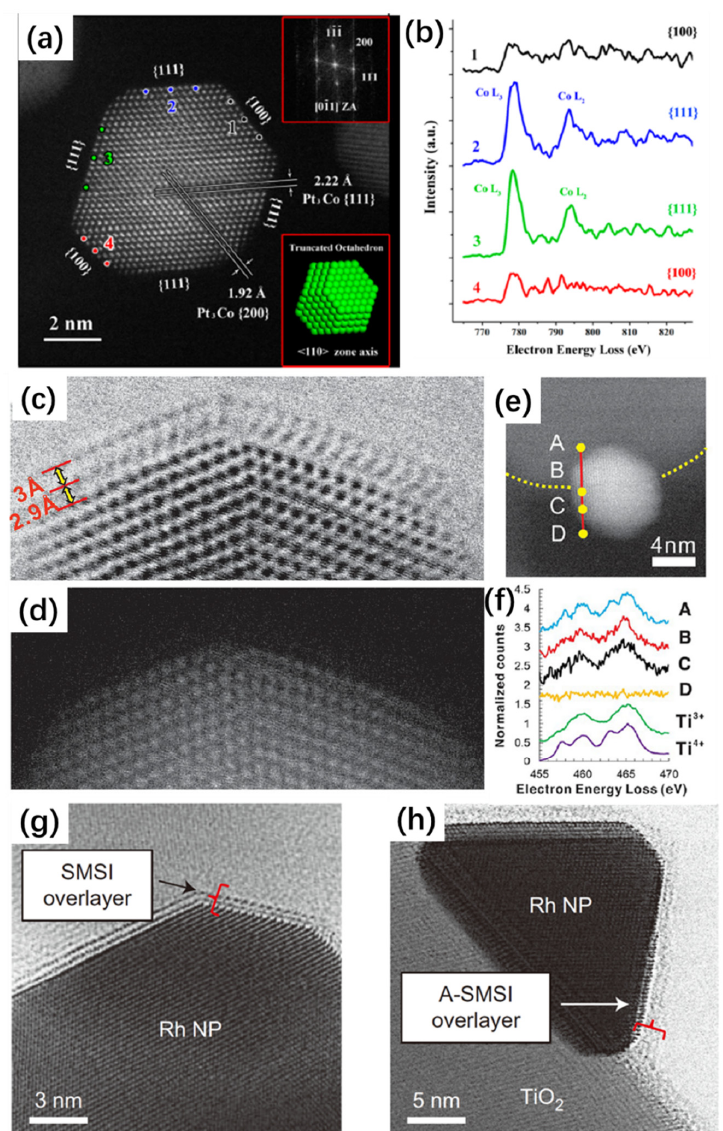
Figure 6. STEM ‐ EELS technique. ( a , b ) [84] Characterization of the original Pt 3 Co NPs ( a ) HAADF image of a Pt 3 Co NP along the < 100 > zone axis. The inserts are the corresponding FFT pattern and the model of a Pt 3 Co NP as a truncated octahedron. ( b ) Average electron energy loss spectroscopy (EELS) spectra of di ff erent facets of the NP at locations marked in ( a ). ( c – f ). Reproduced with the permission from Ref. [84], ACS Publishing Group, 2017 [93]. TiO x overlayer on Pd nanocrystal in Pd / TiO 2 . ( c , d ) A Pd NP surface showing unique double layer TiO x overlayer. ( e ) Another Pd NP sitting on TiO 2 support. ( f ) EELS spectra taken at location marked in ( e ). Reproduced with permission from [93], ACS Publishing Group, 2016. ( g – h ) SMSI and A-SMSI states [94]: ( g ) Rh NP with crystalline SMSI overlayer. ( h ) Rh NP with amorphous SMSI overlayer. Reproduced with permission from [94], Nature Publishing Group,